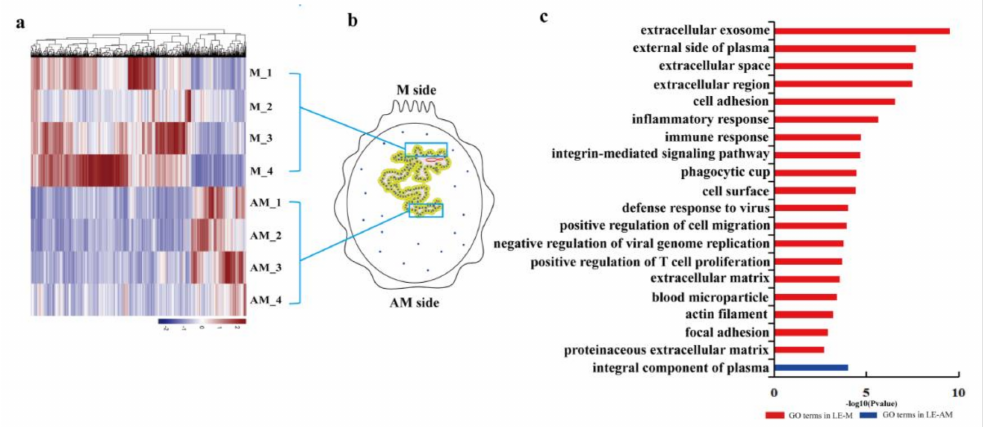
Figure 3. Heatmap and GO analysis for DEGs identified between LE-M and LE-AM on gd15 in pigs. ( a ) Heatmap for DEGs identified in LE-M compared to LE-AM on gd15. ( b ) Schematic illustration of the whole pig uterine cross-section taken from gestational day 15. ( c ) GO analysis of the upregulated DEGs identified in LE-M compared to LE-AM (red), and identified in LE-AM compared to LE-M (blue) on gd15. DEGs: differentially expressed genes; LE-M: endometrial luminal epithelium at the mesometrial side; LE-AM: endometrial luminal epithelium at the anti-mesometrial side; gd15: gestational day 15 (attachment